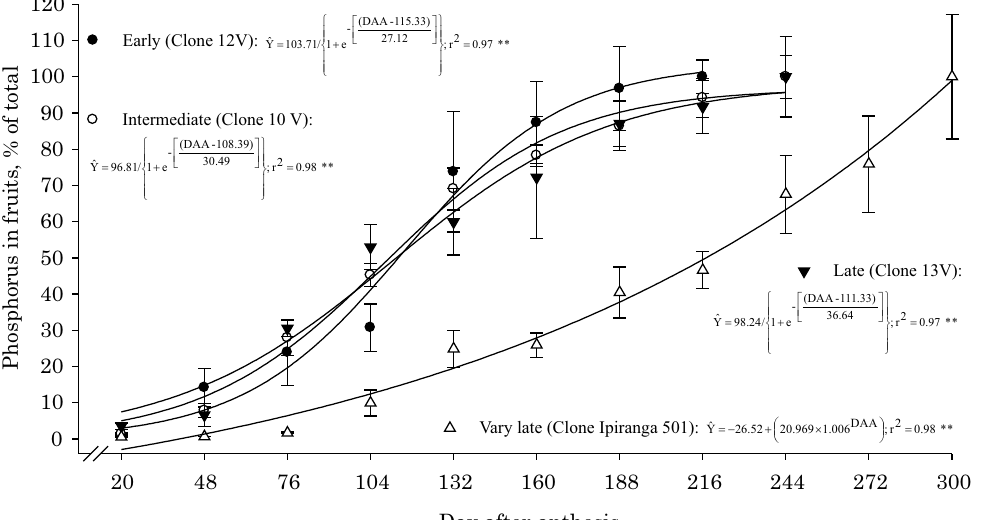
Figure 3. Accumulation of phosphorus in fruits (in percentage of the cumulative total) of four genotypes (clones) of Conilon coffee, from anthesis to fruit maturation. The bars refer to the standard error of the average. ** significant at 1 %